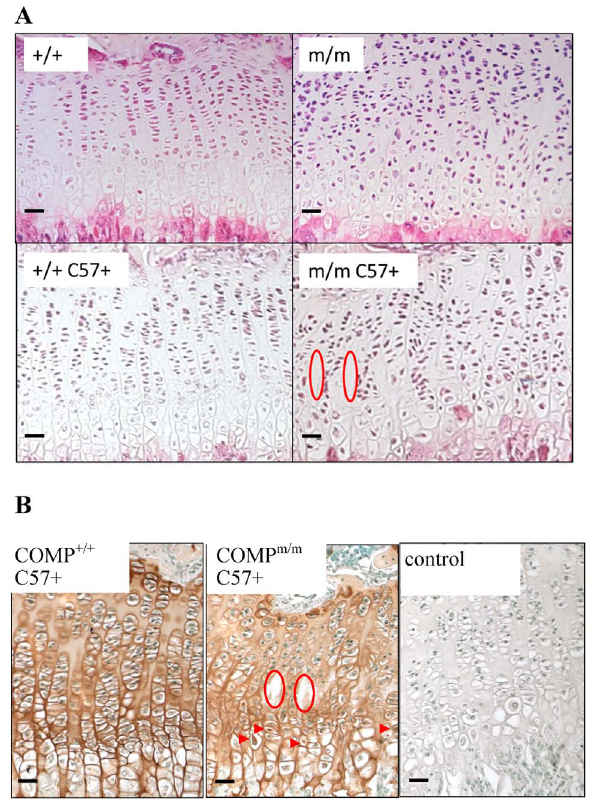
Figure 3. Histochemical and immunohistochemical analysis of growth plate cartilage. A ) Haematoxylin and eosin staining of C57BL6/J enriched wild type ( + / + C57 + ) and T585M COMP mutant (m/m C57 + ) cartilage growth plates at 3 weeks of age showing further disorganisation and more hypocellular areas (red circles) in the m/m C57 + growth plates. B) Immunohistochemistry for COMP at 3 weeks of age showing abnormal columnar organisation of the growth plates in the mutant mice with areas of hypocellularity (red circles) and the retention of COMP in the T585M COMP mutant (COMP m/m C57 + ) hypertrophic zone (red arrowheads) on the C57BL6/J enriched genetic background. Positive COMP staining is brown with green nuclear counterstain. The negative control was generated using the secondary antibody only. Key: + / + =wild type mice (mixed background); + / + C57 + =wild type mice (enriched C57 background); m/m=T585M COMP mutant mice (mixed background); m/m C57 + =T585M COMP mutant mice (enriched C57 background). Scale bar in all images is 100 m